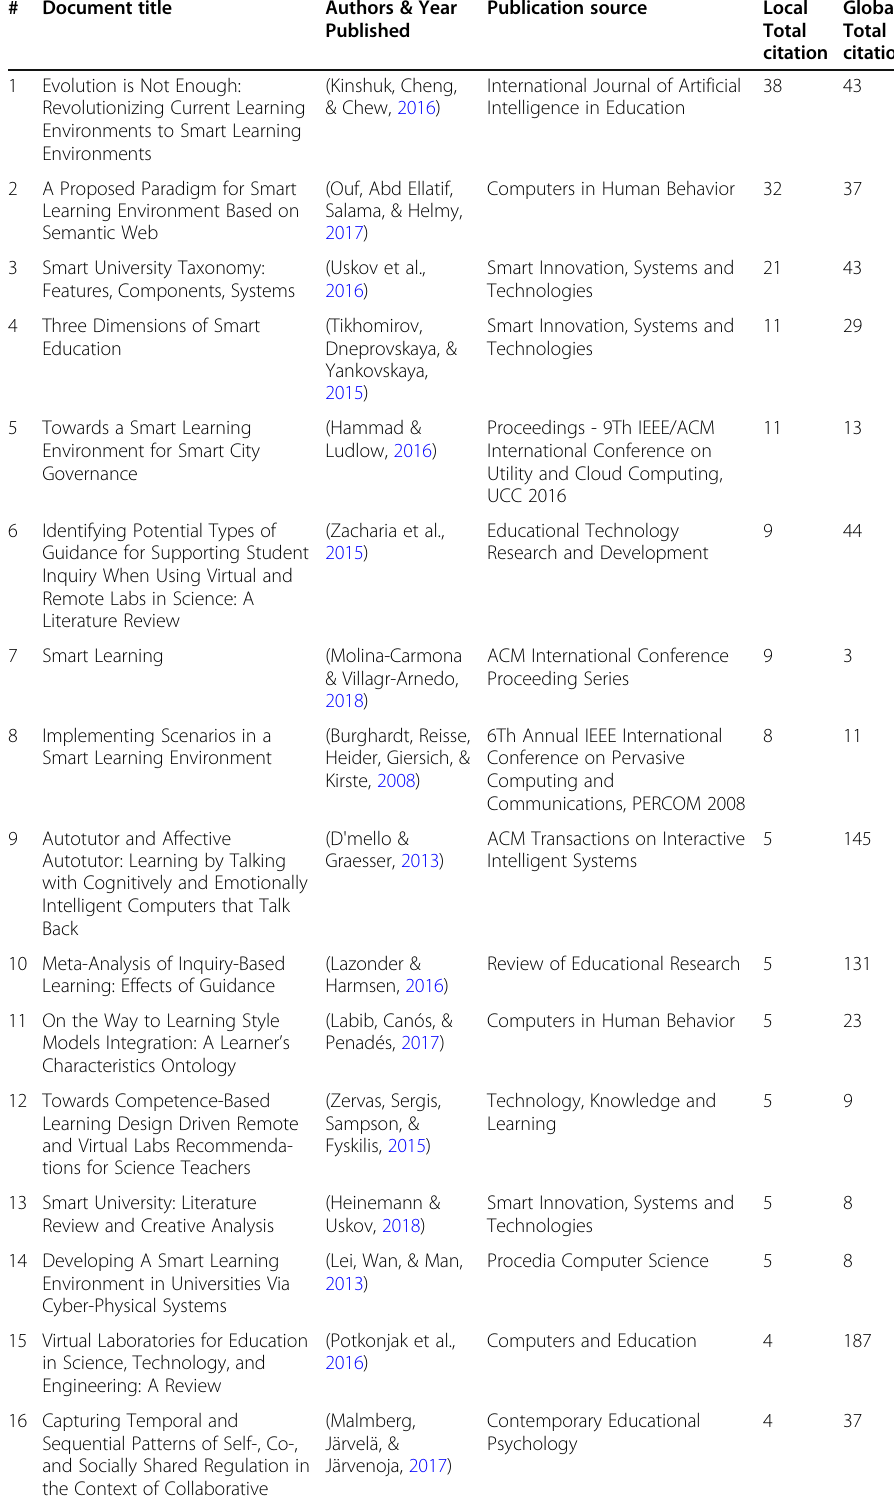
Table 5 Top twenty most cited references based on number of local citations from the collection